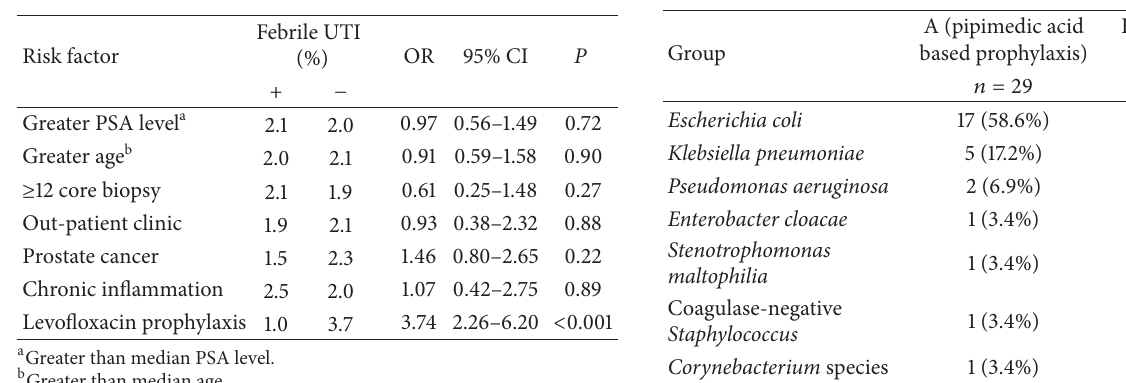
Table 2: The relationship between potential risk factors and febrile UTI rate assessed with multivariate logistic regression analysis.